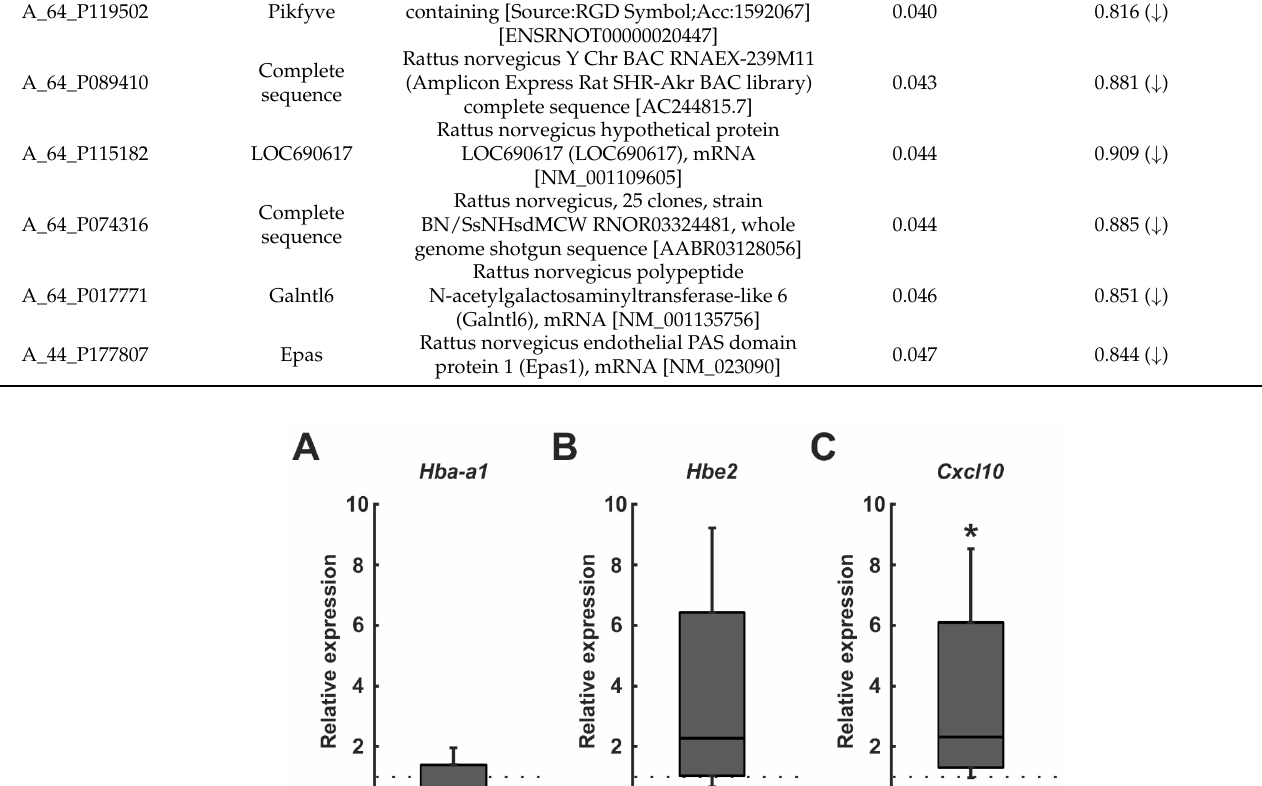
Figure 8. Cxcl10 upregulation. ( A ) RT-qPCR analyses revealed no differences in the Hba-a1 mRNA levels in ONA retinae. ( B ) The mRNA expression levels of Hbe2 were unaltered after ONA immunization. ( C ) An upregulation of the Cxcl10 mRNA expression levels was found in the ONA group ( p = 0.033). Values are median ± quartile ± minimum/maximum. The dotted lines represent the relative expression of the control group. * p < 0.05.